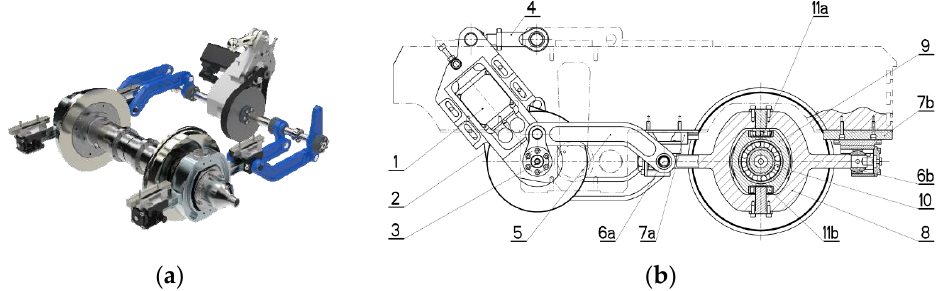
Figure 16. 3D view ( a ) and assembly drawing ( b ) of wheelset steering mechanism.